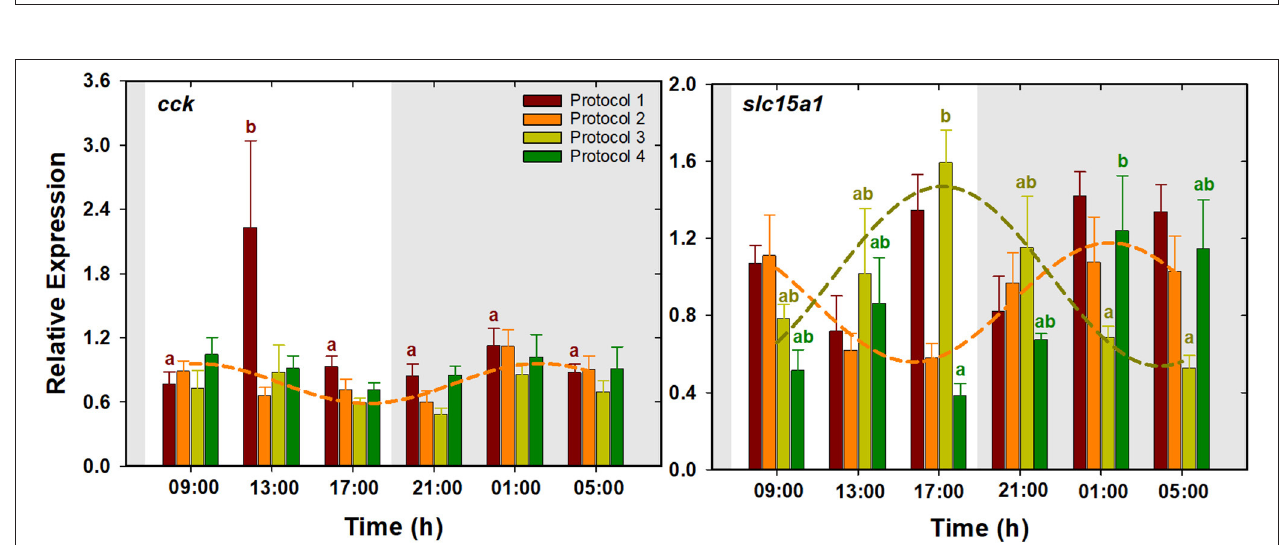
FIGURE 3 | Daily patterns of cck and slc15a1 expression in S. senegalensis with different feeding protocols. The rest of legend as in Figure 2 .